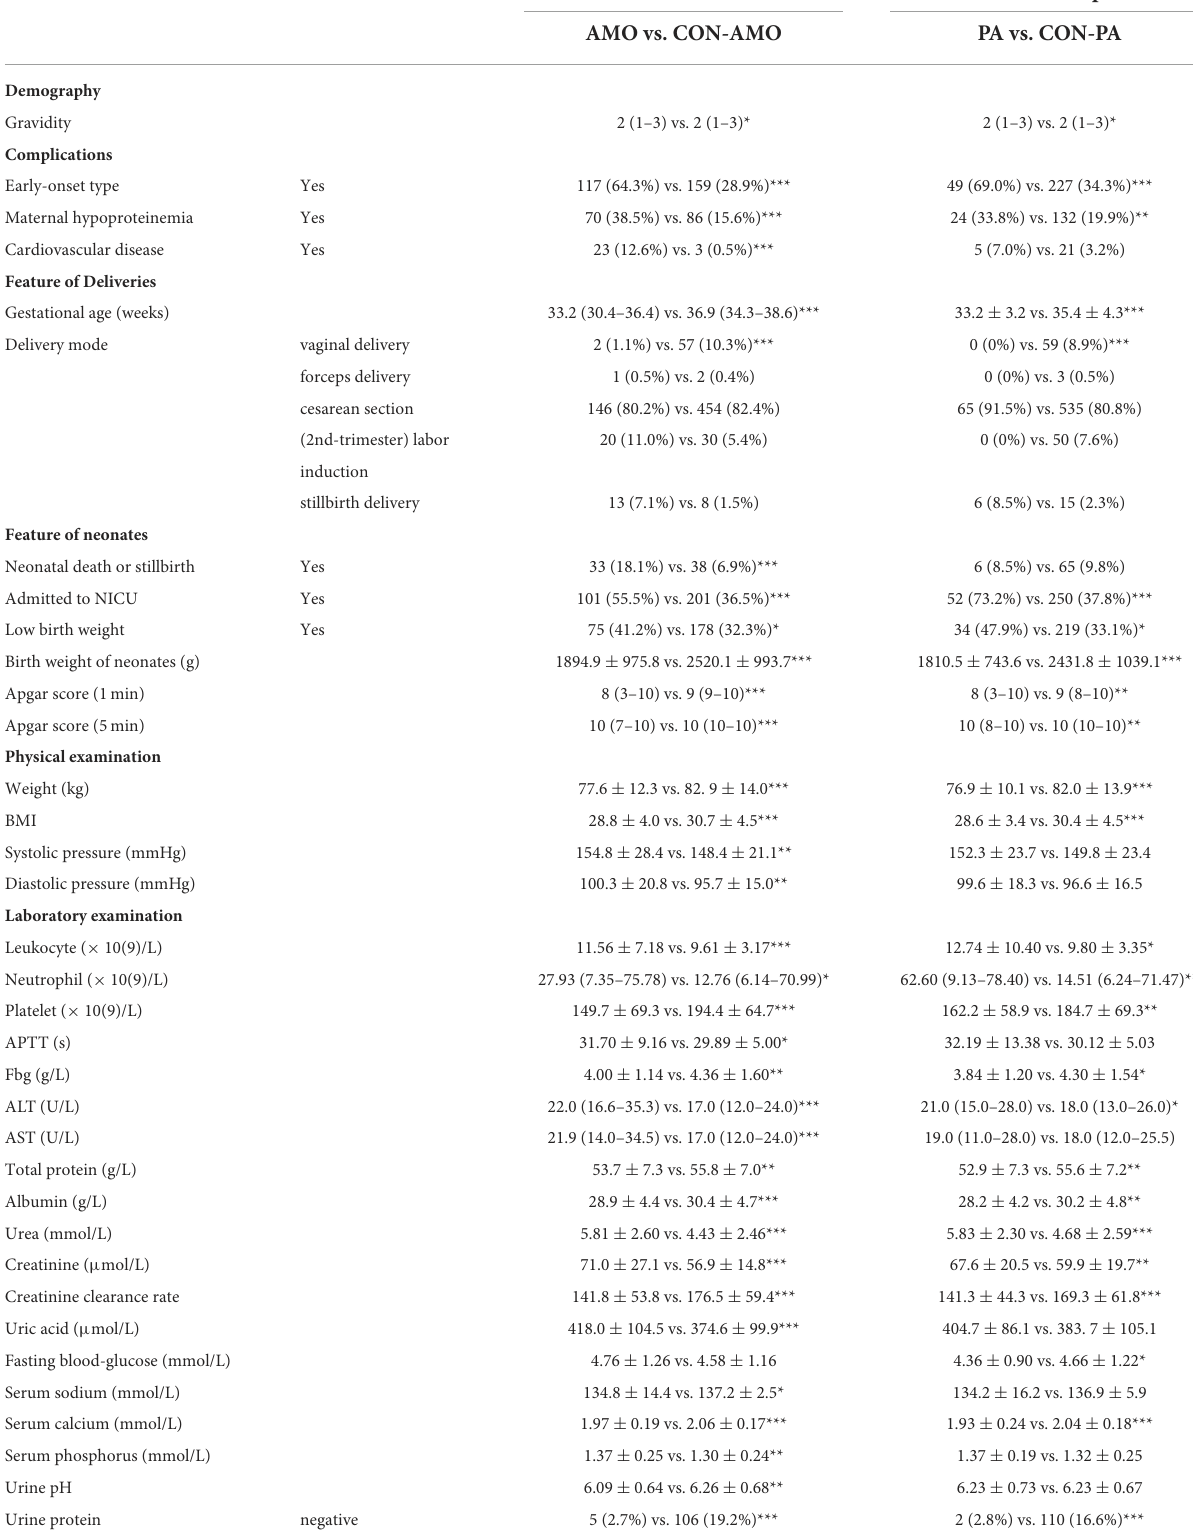
TABLE 1 Variables with statistical significance between adverse maternal outcomes group and control group. Variables Adverse maternal outcomes Placental abruption AMO vs. CON-AMO PA vs.